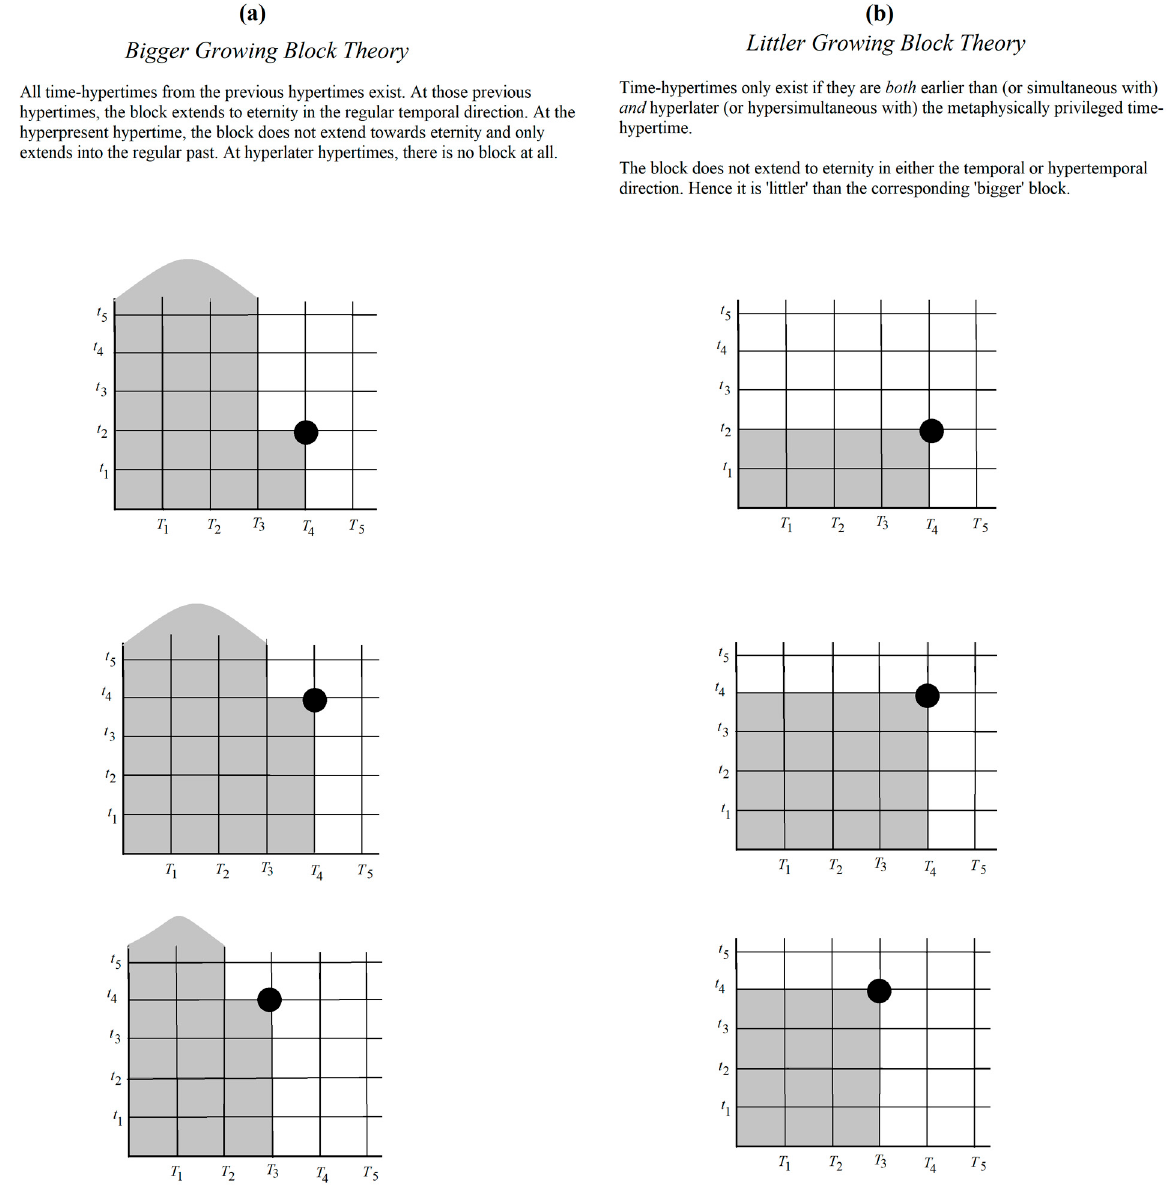
Figure 5. Growing Block Theory & Exterminous Hypertime, ( a ) Bigger Growing Block Theory, ( b ) Littler Growing Block Theory. In each of the diagrams, the black dot indicates which time-hypertime is metaphysically privileged. The greyshading indicates the size of the growing block; every time-hypertime covered by the grey shading exists.